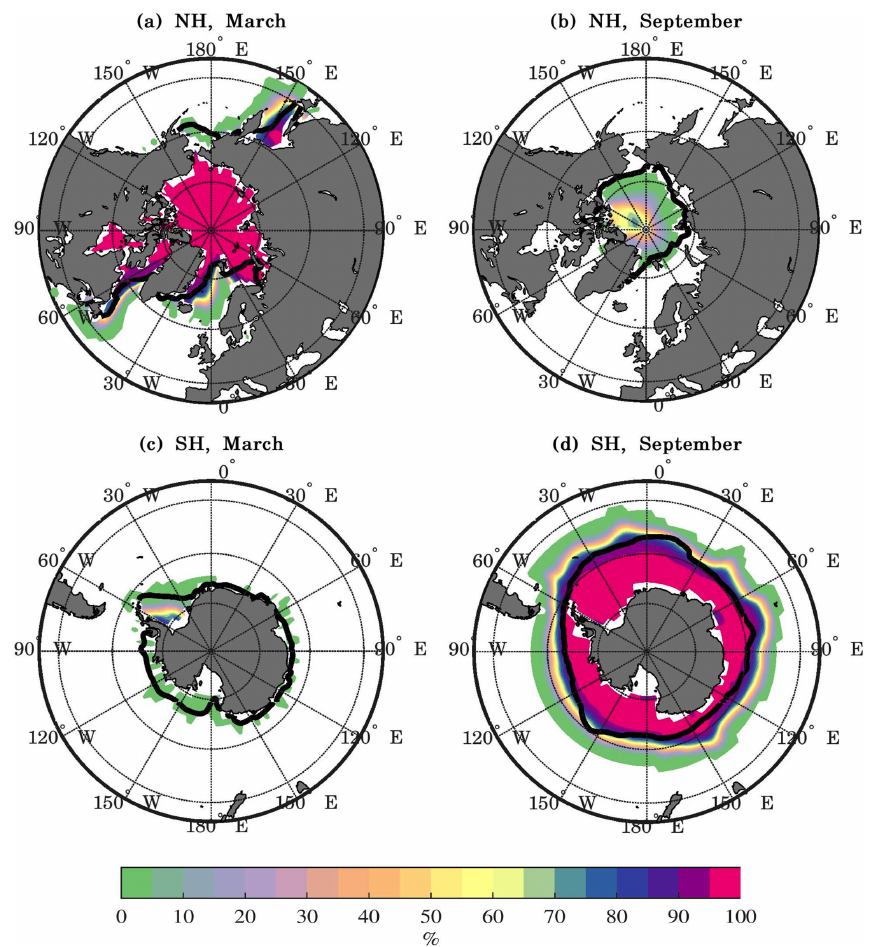
Figure 15. BESM-OA2.5 mean sea ice concentrations for March (a, c) and September (b, d) for each hemisphere. The solid black lines show the 15% mean sea ice concentration from the 20CRv2 reanalysis. The average values were computed over the period 1971–2000 for BESM-OA2.5 and 20CRv2. The concentrations are presented as